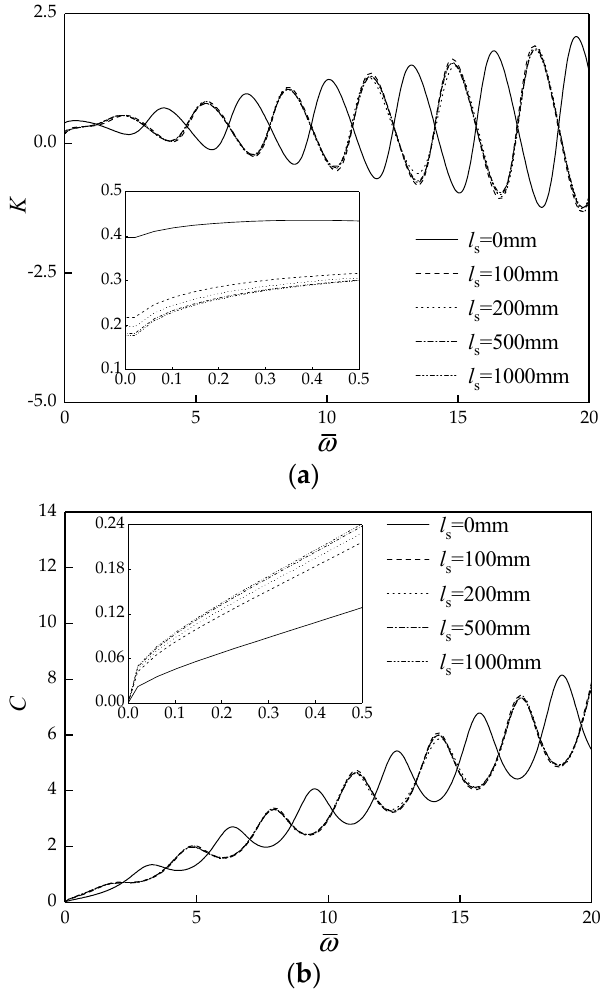
Figure 8. Effect of thickness of sediment on the vertical dynamic impedance of rock-socketed pile in case 2. ( a ) Dynamic stiffness curves; ( b ) Dynamic damping curves.